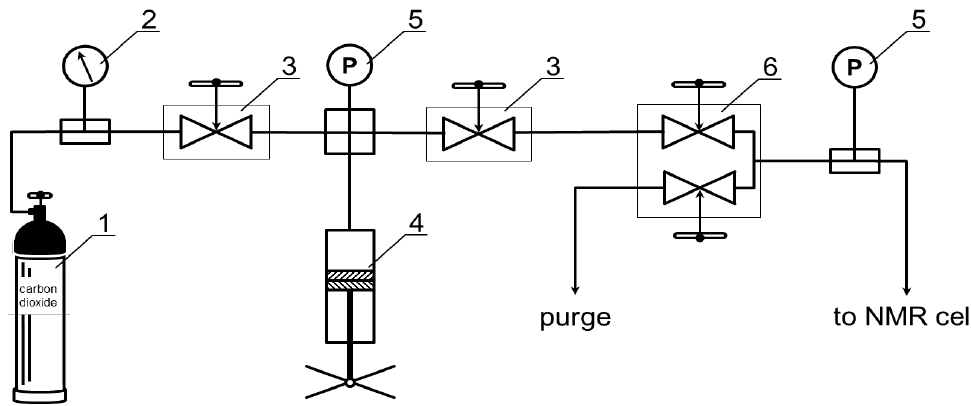
Figure 1. Scheme of the apparatus for producing and maintaining high-pressure for NMR measure- ments in carbon dioxide media, where 1 is a cylinder with carbon dioxide, 2 is a pressure gauge, 3, 6 are taper seal valves for filling ( upper ) and purging ( lower ), 4 is a manual press, 5 and 8 are electronic pressure transmitters, and 9 is a high-pressure NMR cell (see. Figure 2).